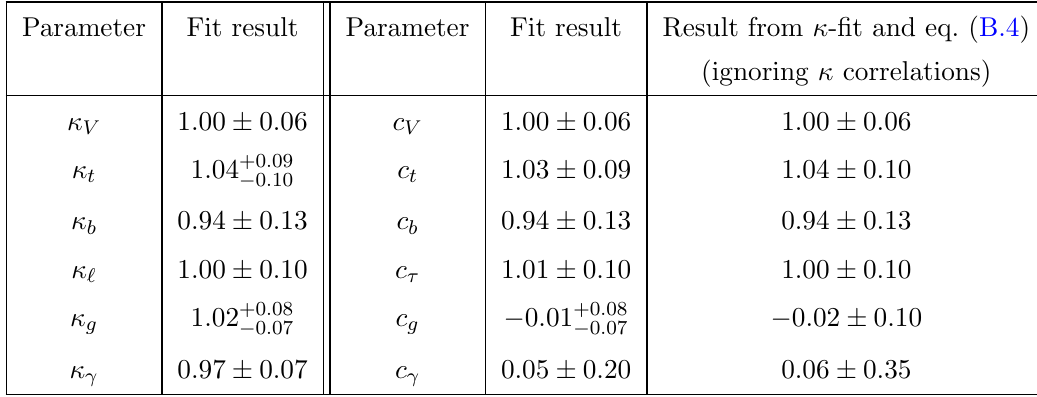
Table 6 . For the (cid:20) formalism, we list the values of the median and the limits of its 68% probability interval. They are confronted with the respective values for a (cid:12)t to the parameters of the chiral Lagrangian (2.2) with c c = c (cid:22) = 1 and c Z(cid:13) = 0. In the last column we show the values of the c i when the result of the (cid:20) i (cid:12)t is translated using eq. (B.4) and ignoring the correlations in the output of the (cid:20) i (cid:12)t. The di(cid:11)erence in the error obtained for c (cid:13) illustrates the importance of